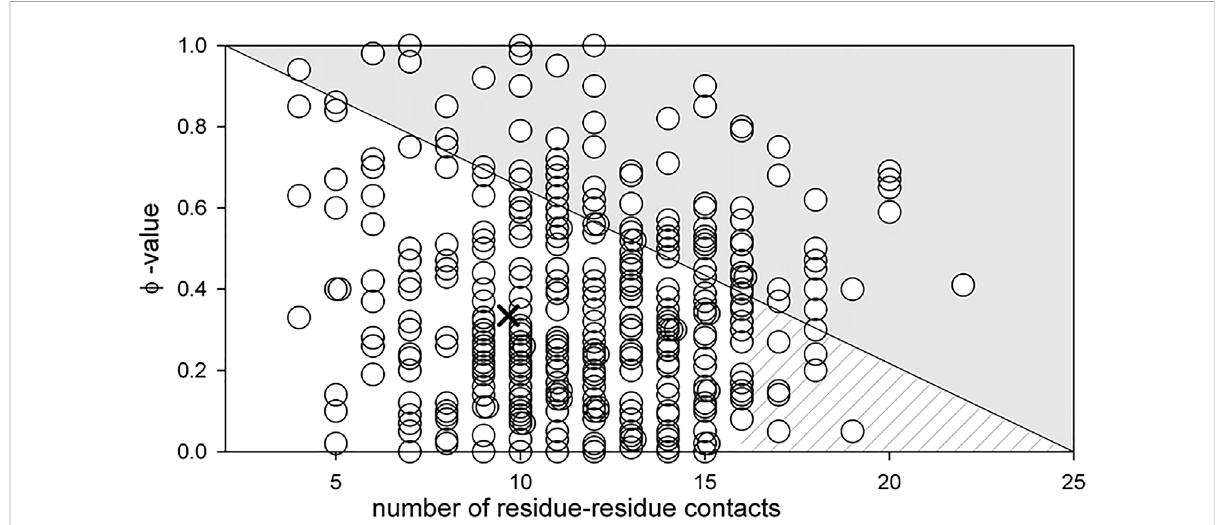
FIGURE 7 Dependence of parameter φ on the number of residue-residue contacts for an amino acid residue ( see (Melnik et al., 2016)). The cross shows themiddleofthelowerwhitetriangle,whichaccordingtotheaboveassumptionshouldcorrespondtotheaveragevalueofparameter φ forallamino acidresidues.Itspositionat φ =0.3iswellcompatiblewiththedata reportedin(Sanchez andKiefhaber,2003)where theaveragevalueofparameter φ ofaminoacidsfromdifferentproteinswascalculated(theaveragevalueof φ variesfrom0.2to0.37fordifferentproteins).Thehatchedpartof the white triangle shows the range of parameter φ values for amino acids with the number of contacts exceeding